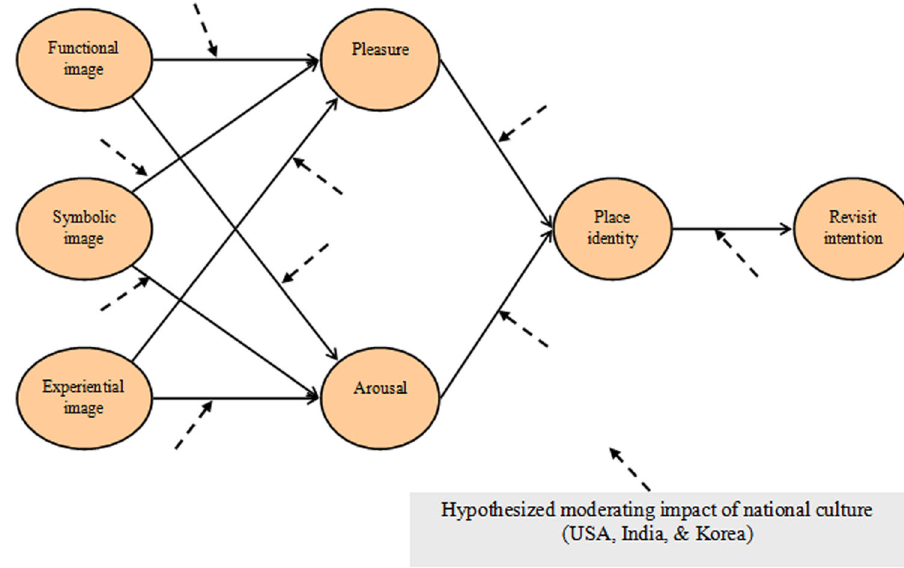
Fig. 1 Proposed theoretical model for State-park tourists ’ approach behaviors.